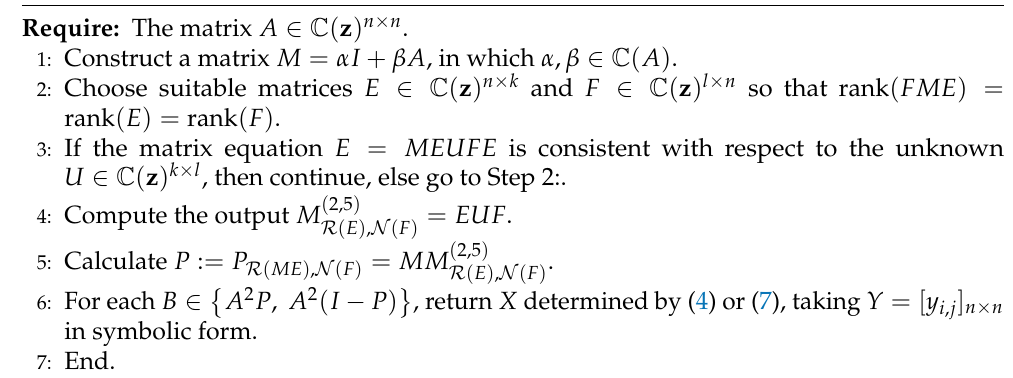
Algorithm 1 Solving the singular (resp. nonsingular) YB-like matrix Equation (1) using Theorem 1 in conjunction with Theorem 3.